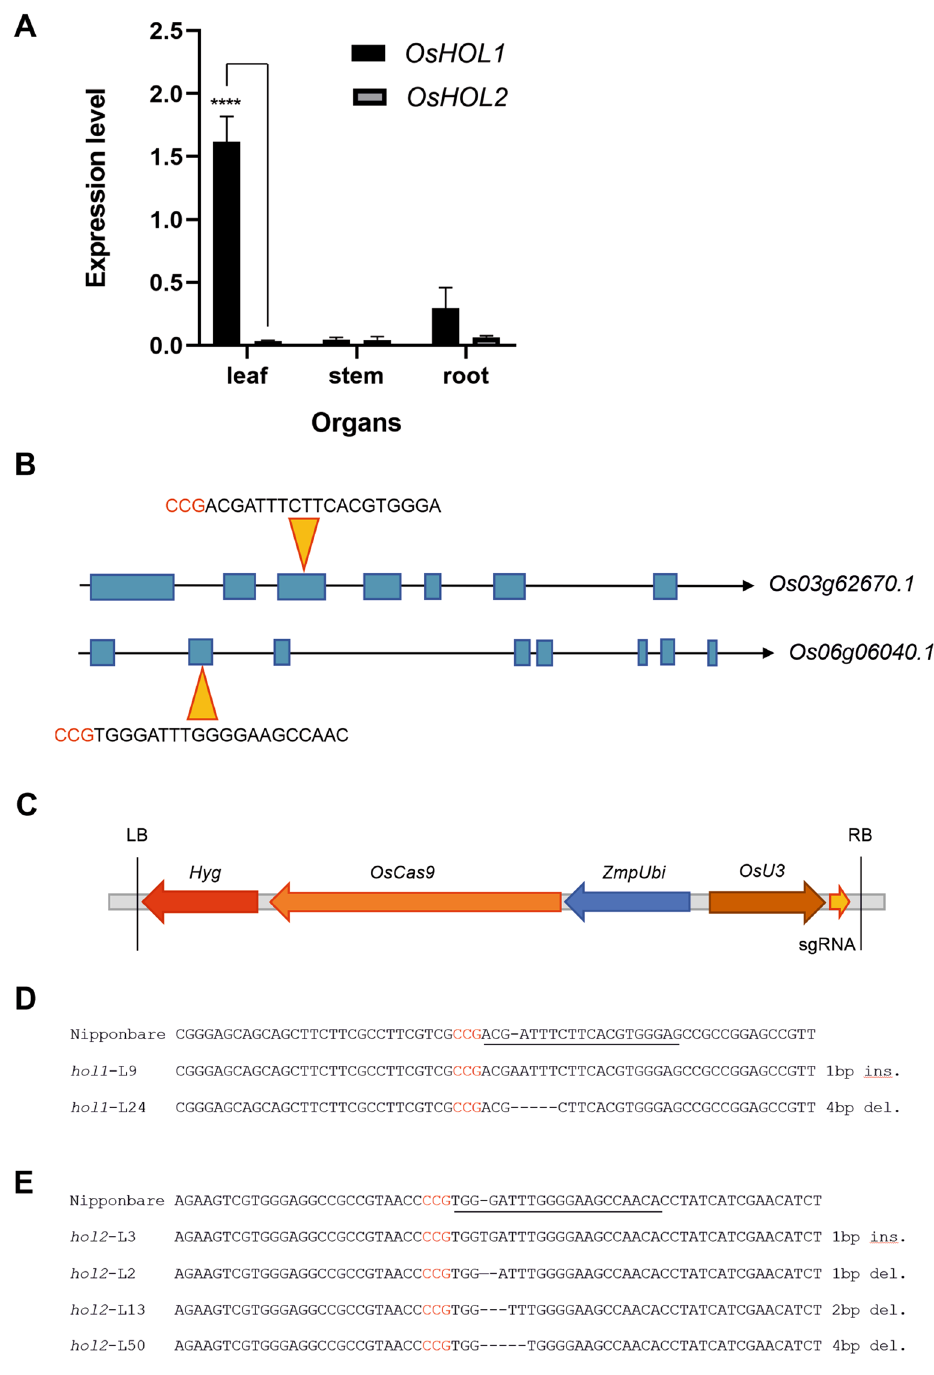
Figure 1. Expression of OsHOL genes in rice plants and CRISPR/Cas9 mutagenesis of the same genes. ( A ) RT-qPCR analysis of OsHOL1 and OsHOL2 in rice plant. Transcript levels were measured in leaves, stems and roots collected from 2-week-old plants. OsHOL expression levels were normalized to the reference gene OsGAPDH . Data points represent means ± s.d. of three biological replicates. T-test analysis was performed between OsHOL1 and OsHOL2 within each organ. Differences are indicated with asterisks. **** mean P ≤ 0.0001. ( B ) Schematic diagrams showing the exon–intron structures corresponding to the longest coding sequences of OsHOL1 ( Os03g62670.1 ) and OsHOL2 ( Os06g06040.1 ). Blue rectangles represent exons, connecting lines represent introns, yellow triangles indicate the position of the target sequence recognized by the gRNA produced for that gene, whose sequence is reported, with the protospacer adjacent motif (PAM) colored in red. ( C ) Schematic diagram of the T-DNA contained in the expression vector used in the study, the Ph-Ubi-CAS9-7-sgRNA vector. LB, left border; Hyg , hygromycin resistance gene; OsCas9 , Cas9 gene sequence optimized for Oryza sativa ; ZmpUbi , Zea mays Ubiquitin1 promoter; OsU3 , Oryza sativa U3 promoter; sgRNA, single-guide RNA sequence; RB, right border. Sequence of OsHOL1 ( D ) and OsHOL2 ( E ) around the gRNA target sequence (highlighted) in wild type Nipponbare plants and in CRISPR/Cas9 mutated lines generated in the study. The type of mutation is reported at the end of each edited sequence. In each sequence the PAM is colored in